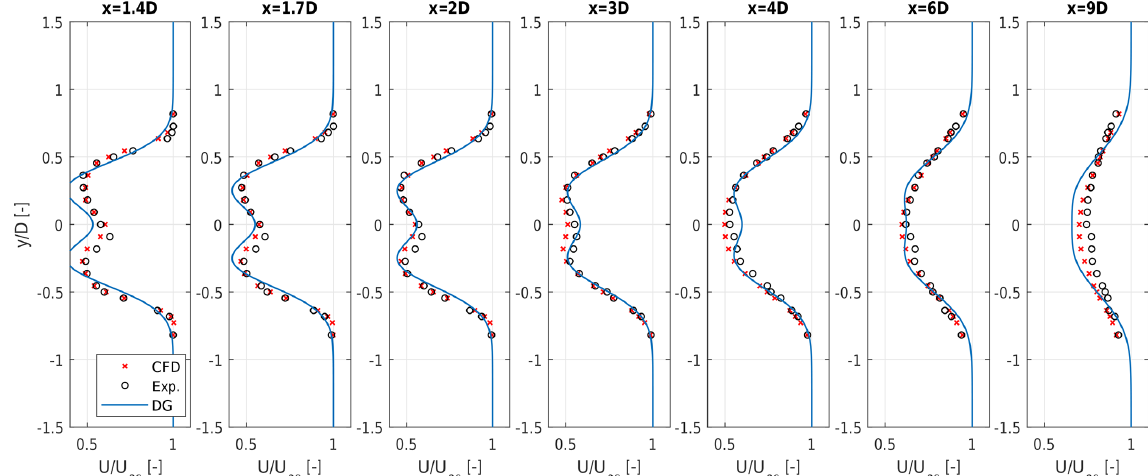
Figure 3. Normalized wind velocity profiles of the double-Gaussian model (solid blue line) compared to experimental measurements (black circles) and CFD simulations (red × symbols). The distances 1.7, 3, and 6D were used for model calibration.